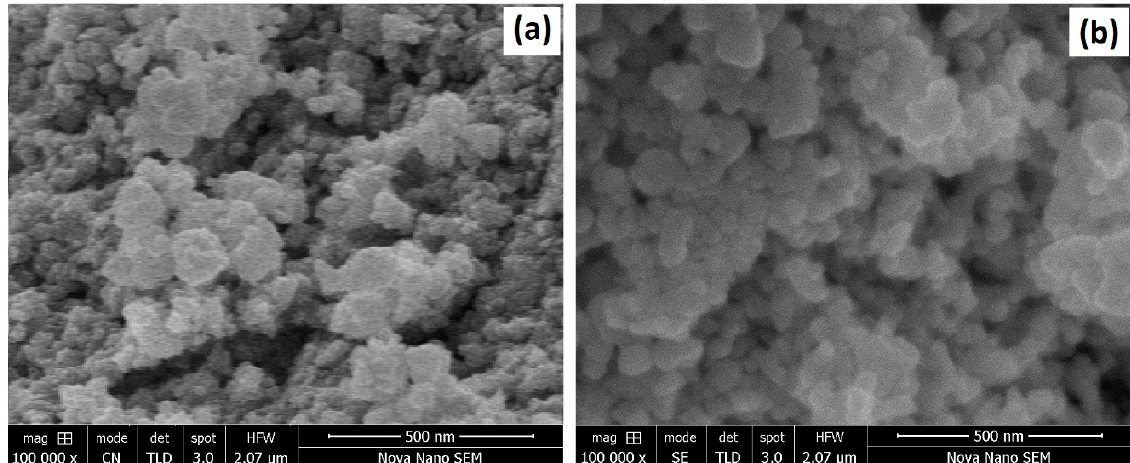
Figure 10. SEM images of the photocatalyst ( a ) before performing dye degradation and ( b ) after performing five dye degradation cycles.